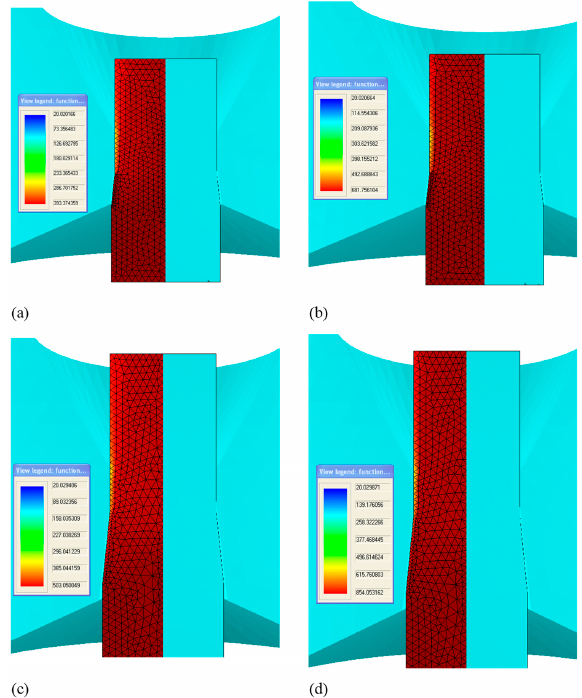
Figure 15. Temperature distribution within the cross-section of final wires drawn according to different drawing variants: ( a ) V c = 1.6 m/s; MG (low single reductions); ( b ) V c = 6.0 m/s; MG (low single reductions); ( c ) V c = 1.6 m/s; DG (high single reductions); ( d ) V c = 6.0 DG (high single reductions).